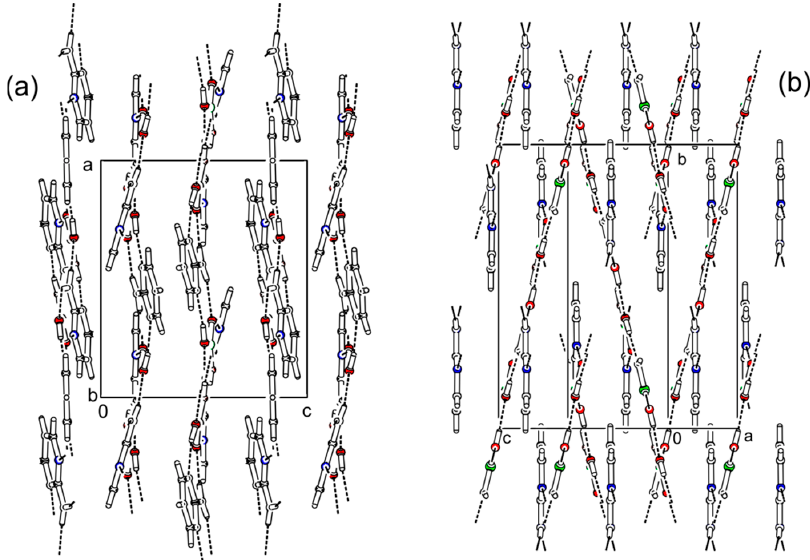
Figure 6. Comparison of crystal packing between (2-AMP) 3 (H 3 BO 3 ) 2 ( a ) and 2-AMP(H 3 BO 3 ) 2 ( b ). Dashed lines indicate hydrogen bonds.